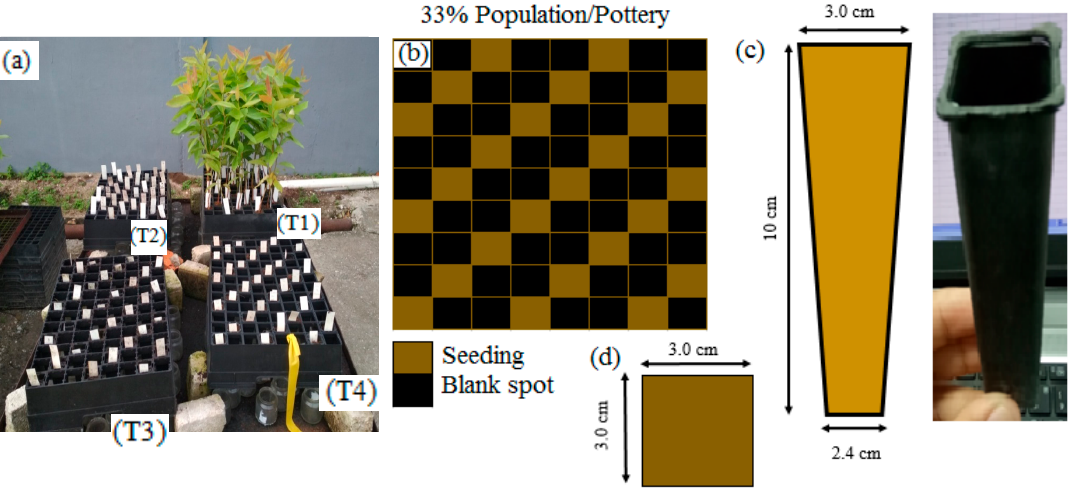
Figure 2. ( a ) Pottery pallets containing tubes of Eucalyptus pellita plants in treatments T1-T4, ( b ) layout of seedlings and blanks in treatment T1, and ( c , d ) side and top view of a tube and its